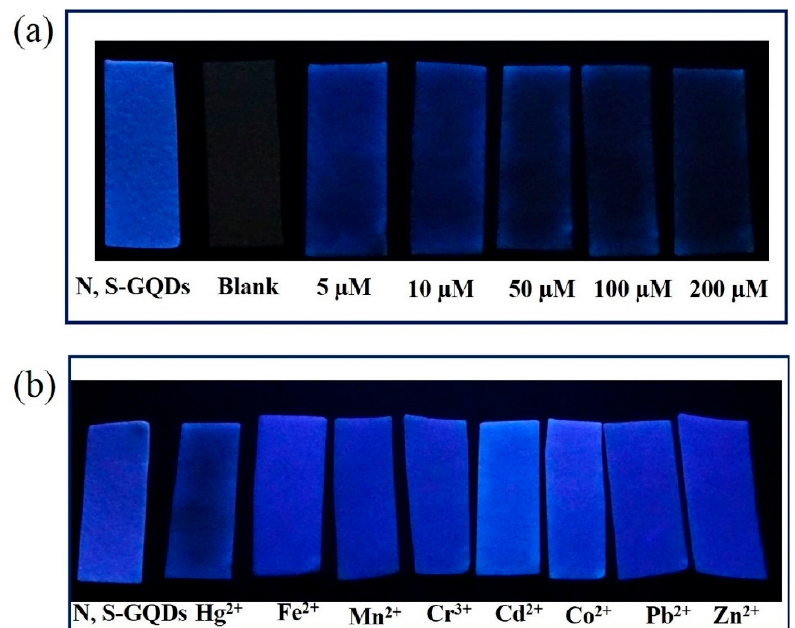
Figure 10. ( a ) Luminescence of blank paper strips and paper strips coated with N-, S-codoped graphene QDs exposed to different Hg 2+ concentrations and ( b ) in the presence of different metal ions in a 100 μ M concentration. Reprinted with permission from [140].